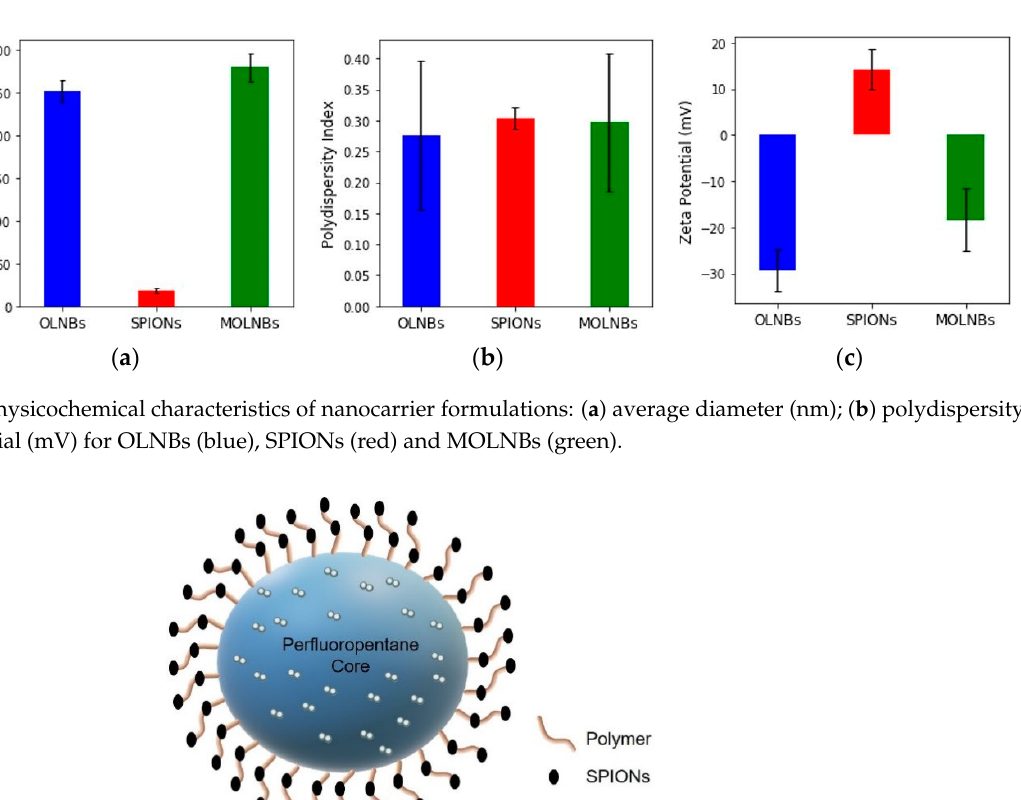
Figure 5. Percentage of inhibition of viability: ( a ) PC-3 tumor cells; ( b ) DU-145 tumor cells.